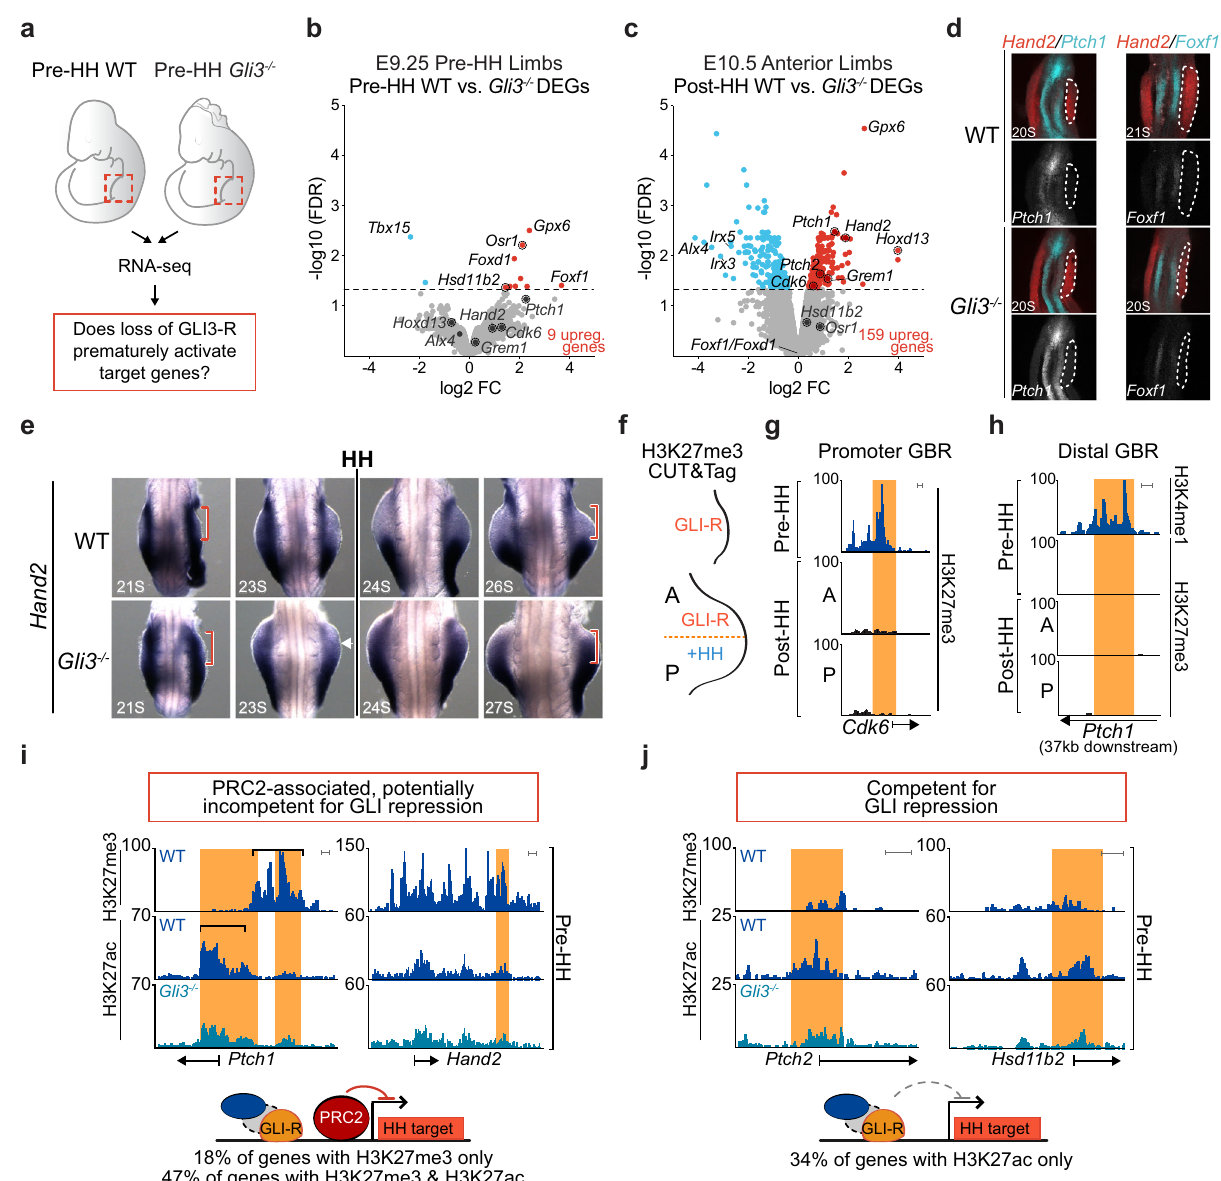
Fig. 4 Most genes are not de-repressed in Gli3 mutants prior to HH induction. a Schematic for testing whether loss of Gli3 can prematurely activate target genes through GLI3 de-repression. b , c Volcano plot of differentially expressed genes (DEGs) detected in RNA-seq between WT and Gli3 − / − limbs E9.25 (21-23 S) ( b ) and E10.5 (32 – 35 S) anterior limb buds ( c ). d Fluorescent in situ hybridization showing maximum intensity projections for Hand2, Foxf1 and Ptch1 in E9.25 WT and Gli3 − / − limb buds indicating the absence of detectable Foxf1 and Ptch1 in pre-HH limb buds. Dashed white lines outline the limb bud region. e In situ hybridization for the GLI3 target Hand2 , in WT and Gli3 − / − limbs pre- (21, 23 S) and immediately post-HH induction (24 – 27 S; n = 3). Note that Hand2 is expressed almost uniformly across the limb bud in 21 S embryos in both WT and Gli3 − / − limbs. At 23 S, slight reduction in anterior expression of Hand2 is observed in both WT and Gli3 − / − limbs (white arrowhead). The red brackets denote anterior limb. Images acquired on a Zeiss LSM 710 Confocal visualized using maximal intensity projections with pseudo-coloring for merged images. f Schematic identifying H3K27me3 enriched regions in E9.25, E10.5 anterior (GLI3-repressed), and E10.5 posterior (HH signaling, loss of GLI-R) limb buds using CUT&Tag. g – j Orange shading in tracks indicates HH-responsive GBRs de fi ned in Supplementary Fig. 1e. g Example of a HH-responsive GBR at a HH target gene promoter with H3K27me3 enrichment speci fi cally at E9.25 but not E10.5. h Representative distal limb-speci fi c HH-responsive GBR downstream of Ptch1 with no H3K27me3 enrichment in E9.25 or E10.5 limb buds. i Examples of HH target genes associated with polycomb repression that could potentially be incompetent for GLl3 repression. j Examples of genes that are bound by GLl3 at E9.25, contain H3K27ac enrichment and lack H3K27me3 enrichment, suggesting they are competent for GLl3 repression but are not de-repressed in the absence of Gli3 . For f – j see Supplementary Data 1. Scale bars for tracks indicate 1 kb. WT and Gli3 − / − embryos to look for subtle changes that might buds, with most WT limb buds expressing anterior Hand2 at not be detected by RNA-seq. Hand2 is initially expressed levels comparable to those seen posteriorly. However, comparably throughout anterior WT limb buds (Fig. 4d, e) similar to lower levels of anterior Hand2 expression were present even in Gli3 − / − limb buds (20 – 23 S) ( n = 7). At early post-HH stages some Gli3 − / − limb buds (Fig. 4e, white arrow). Posterior (24 – 26 S), Hand2 expression is variable in WT and Gli3 − / − limb restriction of Hand2 is not evident until 26 S and is still variable NATURE COMMUNICATIONS| (2022) 13:808